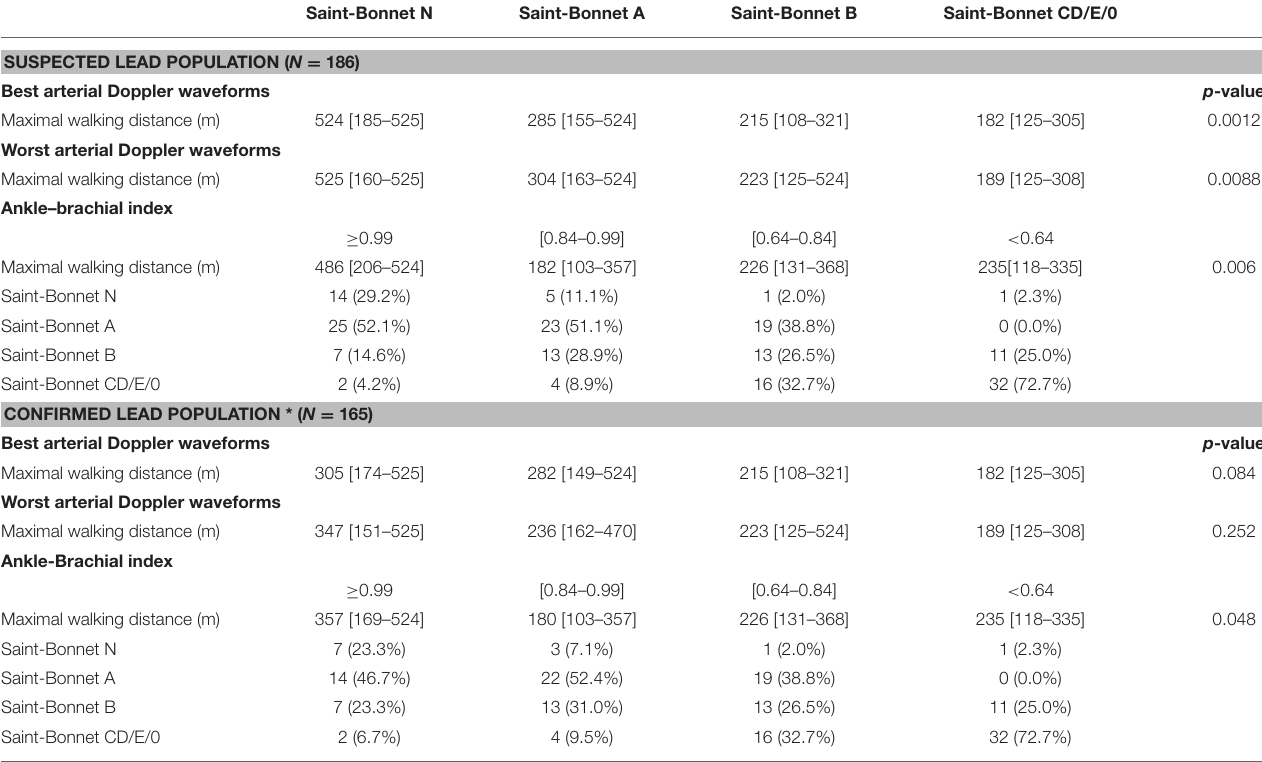
TABLE 2 | Maximal walking distance according to Saint-Bonnet Classification and